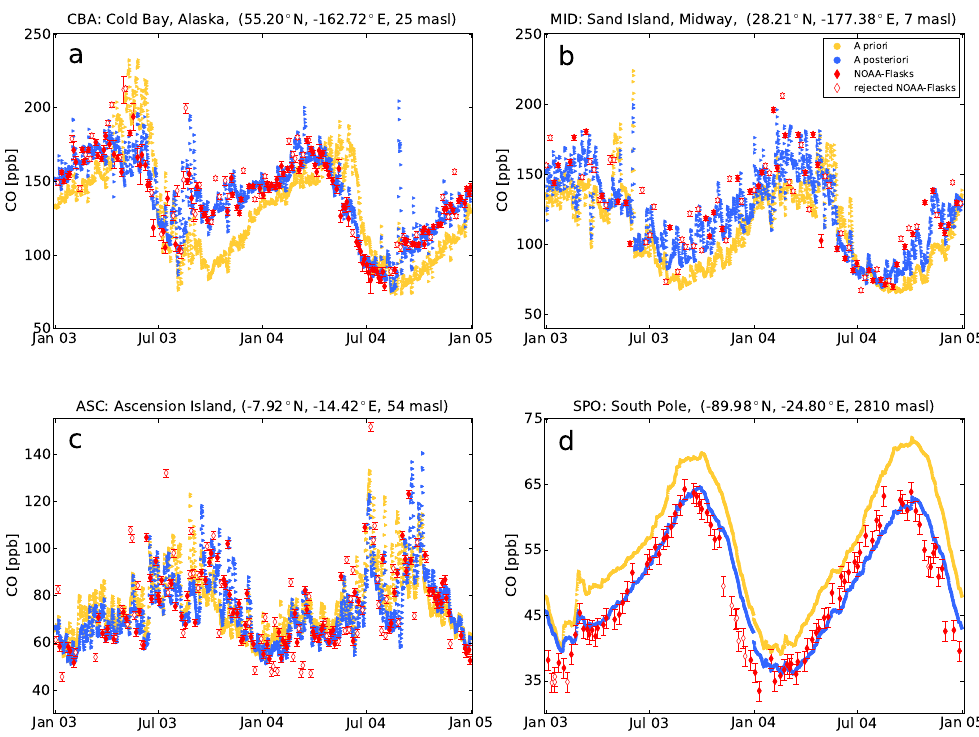
Fig. 2. Comparison of modeled and observed CO mixing ratios at (a) Cold Bay, Alaska, (b) Sand Island, Midway, (c) Ascension Island and (d) South Pole station from the NOAA surface network. Red dots correspond to NOAA observations, red open markers represent rejected data from inversion cycle 1 to cycle 2. Model simulations using prior (posterior) settings are shown in yellow